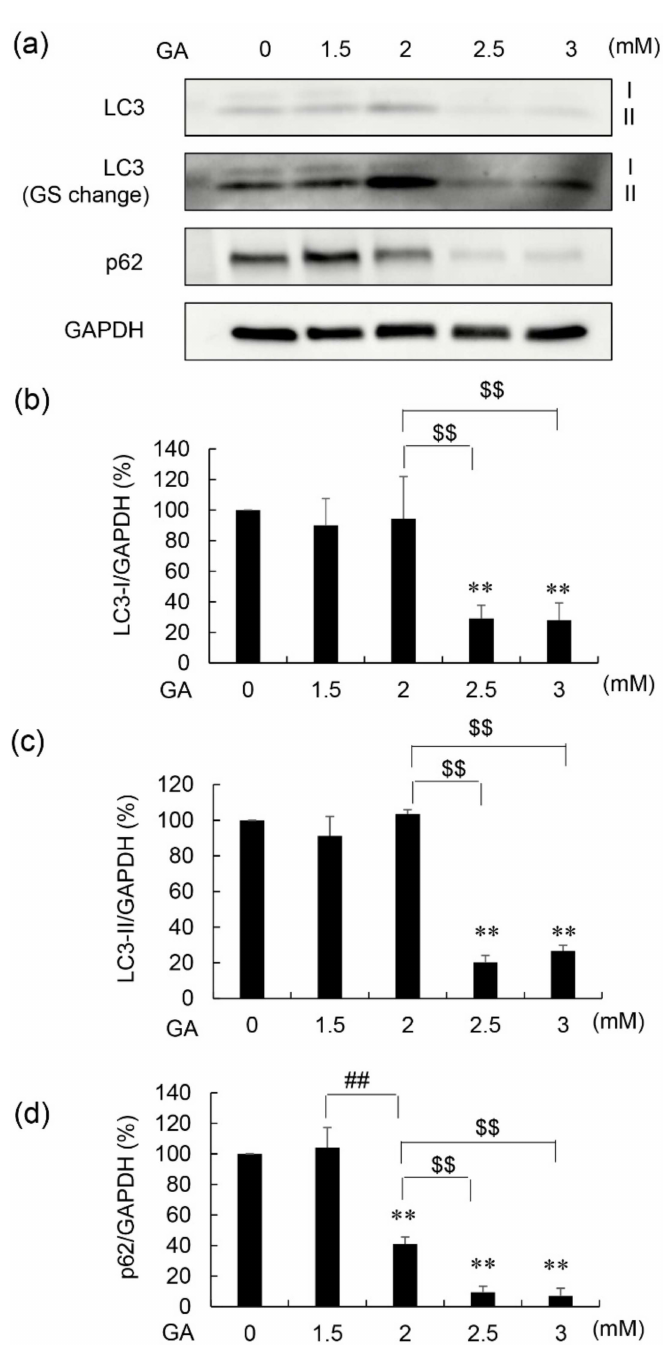
Figure 2. Western blot (WB) analysis of LC3 and p62 protein levels in 1.4E7 cells treated with GA. Cells were treated with 0–3 mM GA for 24 h. Lysates from 1.4E7 cells were loaded onto 4–15% polyacrylamide gradient gels (Ten µ g of proteins per lane). This analysis was performed to evaluate cell viability in three independent experiments. ( a ) Proteins on PVDF membranes were targeted with anti-LC3, anti-p62, and anti-GAPDH antibodies. GS: gray scale. Gray scale change: the value of the gray scale was 5000 in Fusion FX software. WB analysis was performed in three independent experiments. GAPDH was used as the loading control. I and II show the LC3-I and -II position. ( b ) Protein levels of LC3-I were normalized to those of GAPDH. ( c ) Protein levels of LC3-II were normalized to those of GAPDH. ( d ) Protein levels of p62 were normalized to those of GAPDH. ( b – d ) Data are shown as the mean ± S.D. ( n = 3). p -values were based on Tukey’s test. ** p < 0.01 vs. 0 mM GA. ## p < 0.01 vs. 1.5 mM GA. $$ p < 0.01 vs. 2 mM